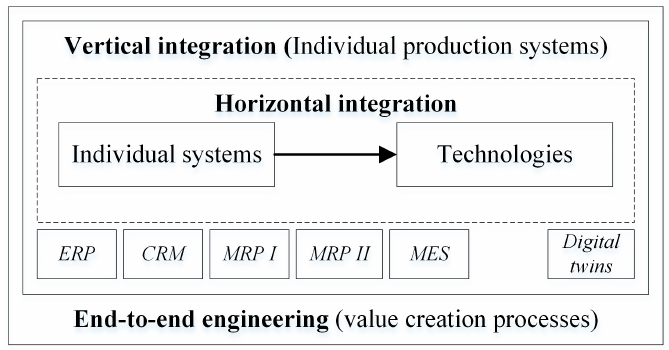
Figure 2. Relations of approaches in Industry 4.0.